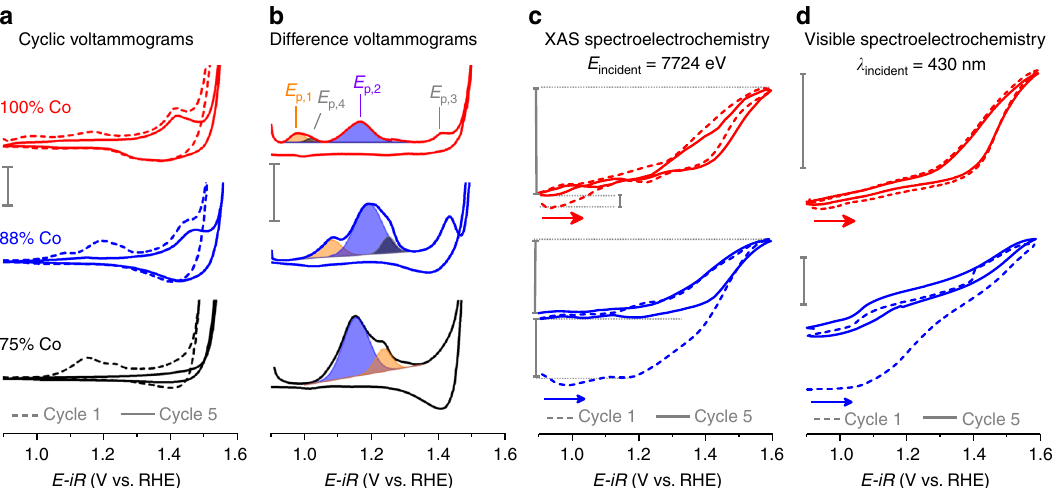
Fig. 1 Electrochemical and spectroelectrochemical behavior of representative Fe – Co oxides. a The fi rst and fi fth voltammetric cycles recorded at 10 mV s − 1 in 1 M KOH (aq) . Scale bar represents 1 mA cm − 2 . b Difference voltammograms obtained by subtraction of cycle 5 from cycle 1; colored peaks depict the anodic shifting of the major irreversible components. Scale bar represents 0.2 mA cm − 2 . c Shift in the Co- K-edge position ( Δ E edge ) during in situ X-ray absorption spectroscopy-cyclic voltammetry (XAS-CV) experiments for 100% Co and 88% Co. Scale bars, listed from top to bottom, represent 0.83 ( Δ E edge,rev. ), 0.05 ( Δ E edge,irrev. ), 0.67 ( Δ E edge,rev. ), and 0.45 eV( Δ E edge,irrev. ). d Change in transmittance during cyclic voltammetry experiments for 100% Co and 88% Co. Voltammetric data shown was acquired during visible spectroelectrochemical experiments. Scale bars represent 0.05 absorbance units. Data for the remaining compositions in series is available in Supplementary Fig.